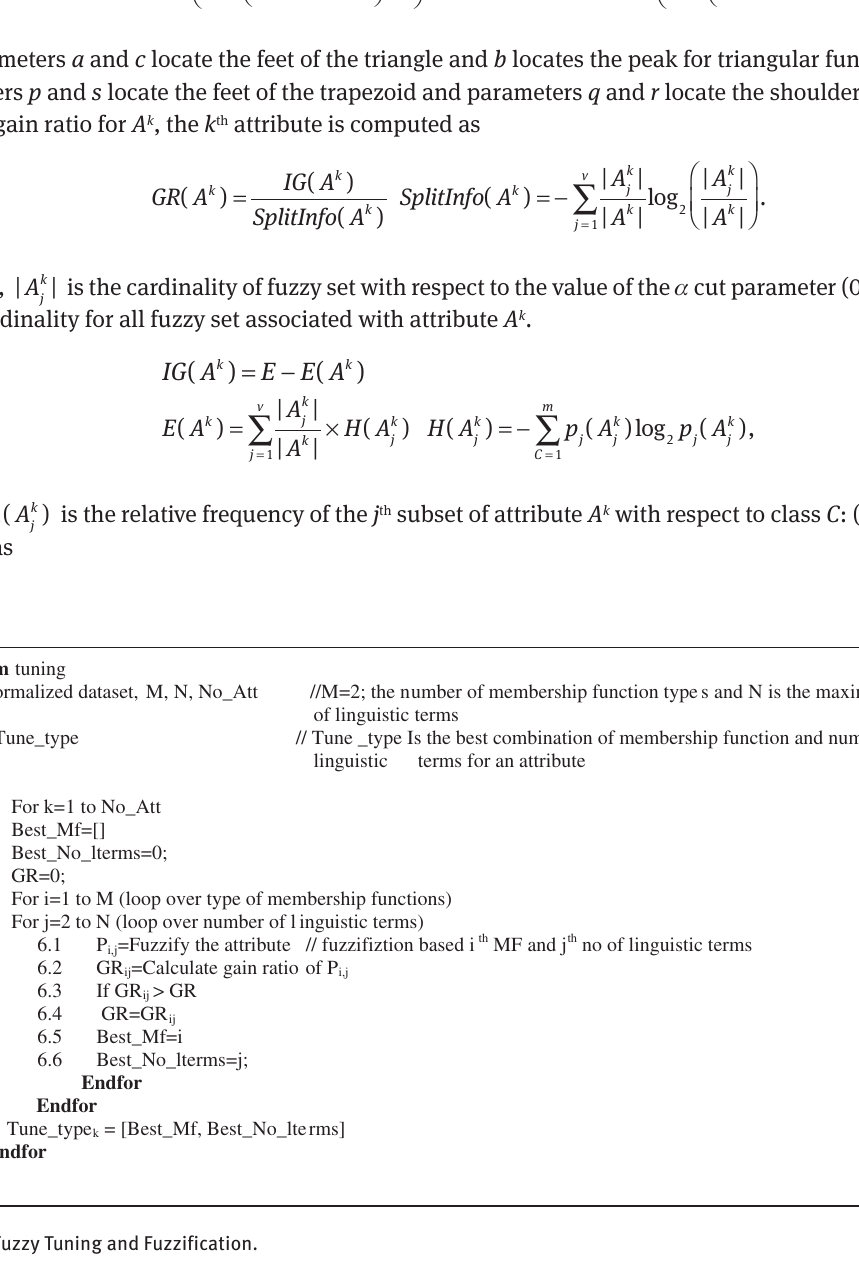
Figure 1: Fuzzy Tuning and